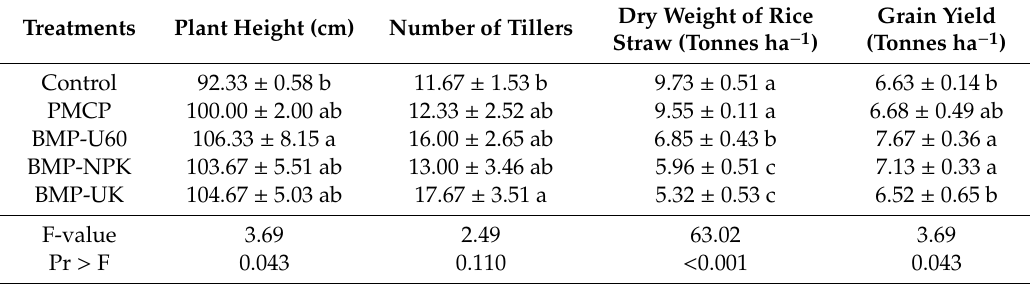
Table 6. Characteristics of rice growth to supplemented biochar manure pellet fertilizer application.